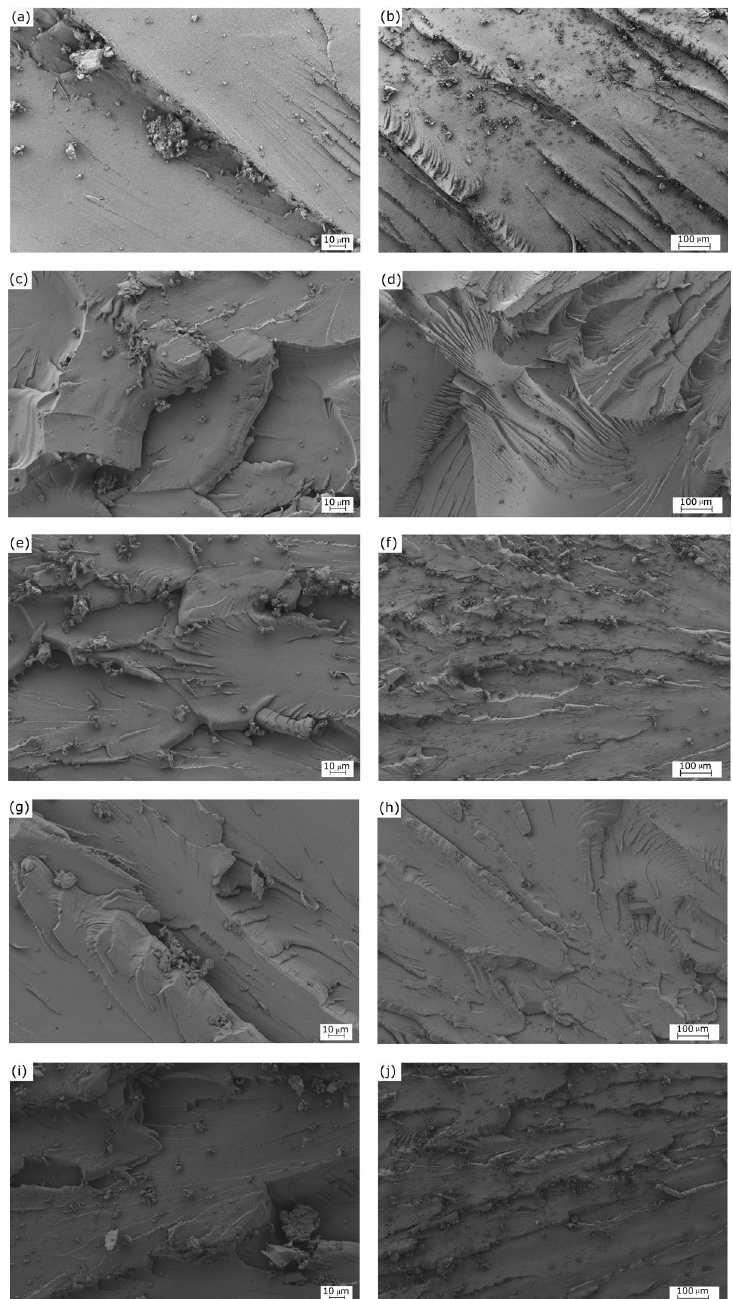
Figure 2. Field-emission scanning electron microscopy (FESEM) corresponding to the fracture surfaces from impact tests of the partially bio-based epoxy resins subjected to standard curing (SC) and post-curing (PC) treatments: ( a , b ) SC 80 ; ( c , d ) SC 80 PC 125 ; ( e , f ) SC 80 PC 150 ; ( g , h ) SC 70 PC 125; ( i , j ) SC 90 PC 125 . Images were taken at 500 × (left column) and 100 × (right column), with scales of 10 µ m and 100 µ m, respectively.